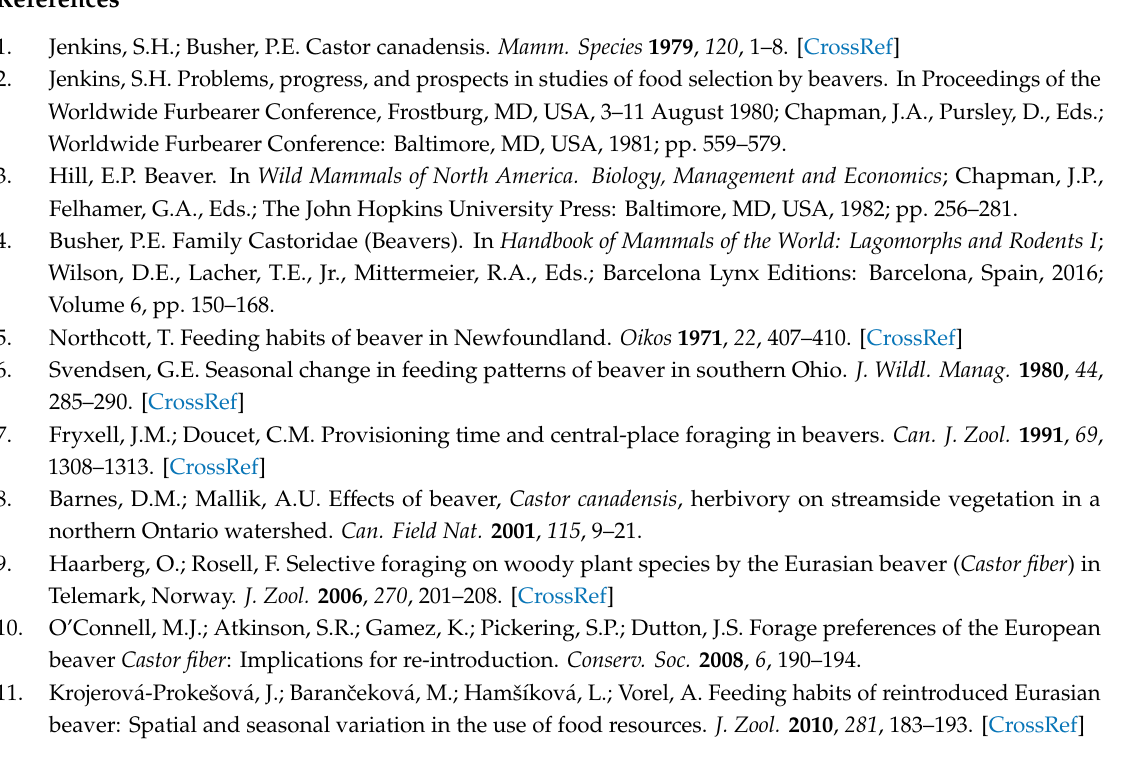
Table S1. Plants inventoried along the Gwda River on six transects, with information about shoot diameter, location (transect number), anthropopression level (in points), plant species, the genus name used in analysis, information if the plant was browsed and distance from the river bank. Table S2. Electivity index values for woody plants inventoried in each transect located along the Gwda River in three diameter classes for selected woody